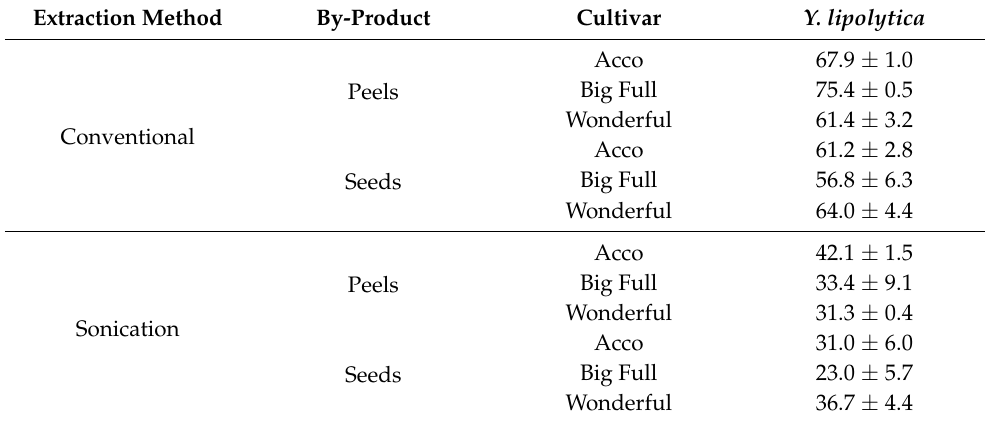
Table 8. Antimicrobial activity index (%) for peels and seeds extracts of Acco, Big Full, and Wonderful cultivars, from both extractions, relatively to amphotericin